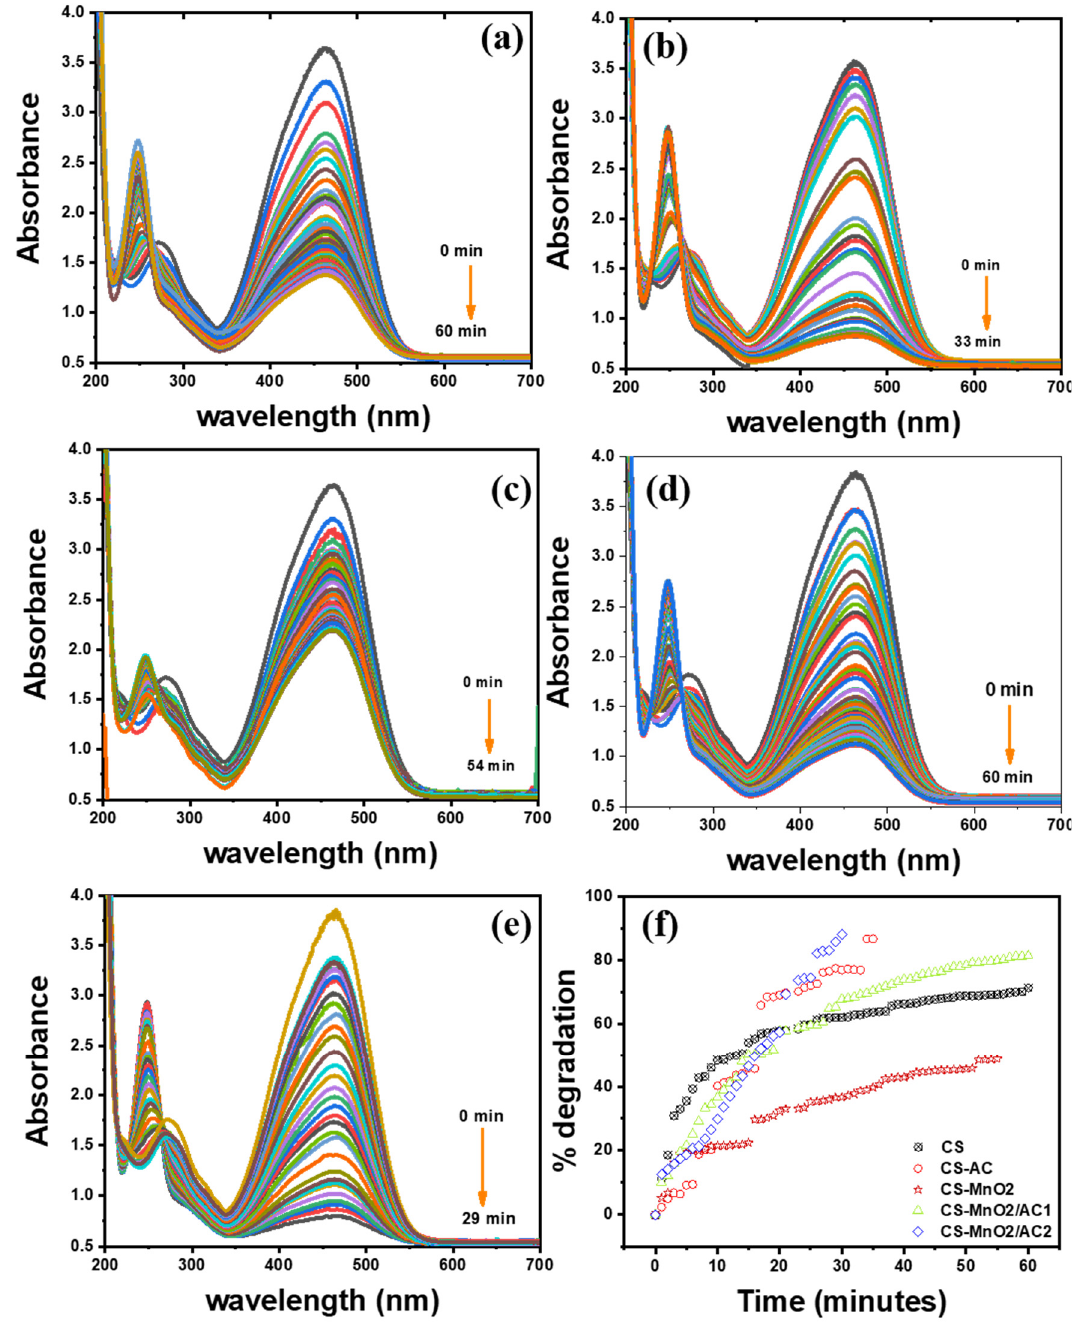
Figure 5. Absorbance spectrum of MO degradation in the presence of NaBH 4 by using CS@Co ( a ), CS-AC@Co ( b ), CS-MnO 2 @Co ( c ), CS-MnO 2 /AC1@Co ( d ) and CS-MnO 2 /AC2@Co NPs ( e ) and % degradation of MO dye ( f ). Experimental conditions: 2.5 mL of 0.1 mM MO solution; 0.5 mL of 0.5 mM NaBH 4 solution and 20 mg of each catalyst.